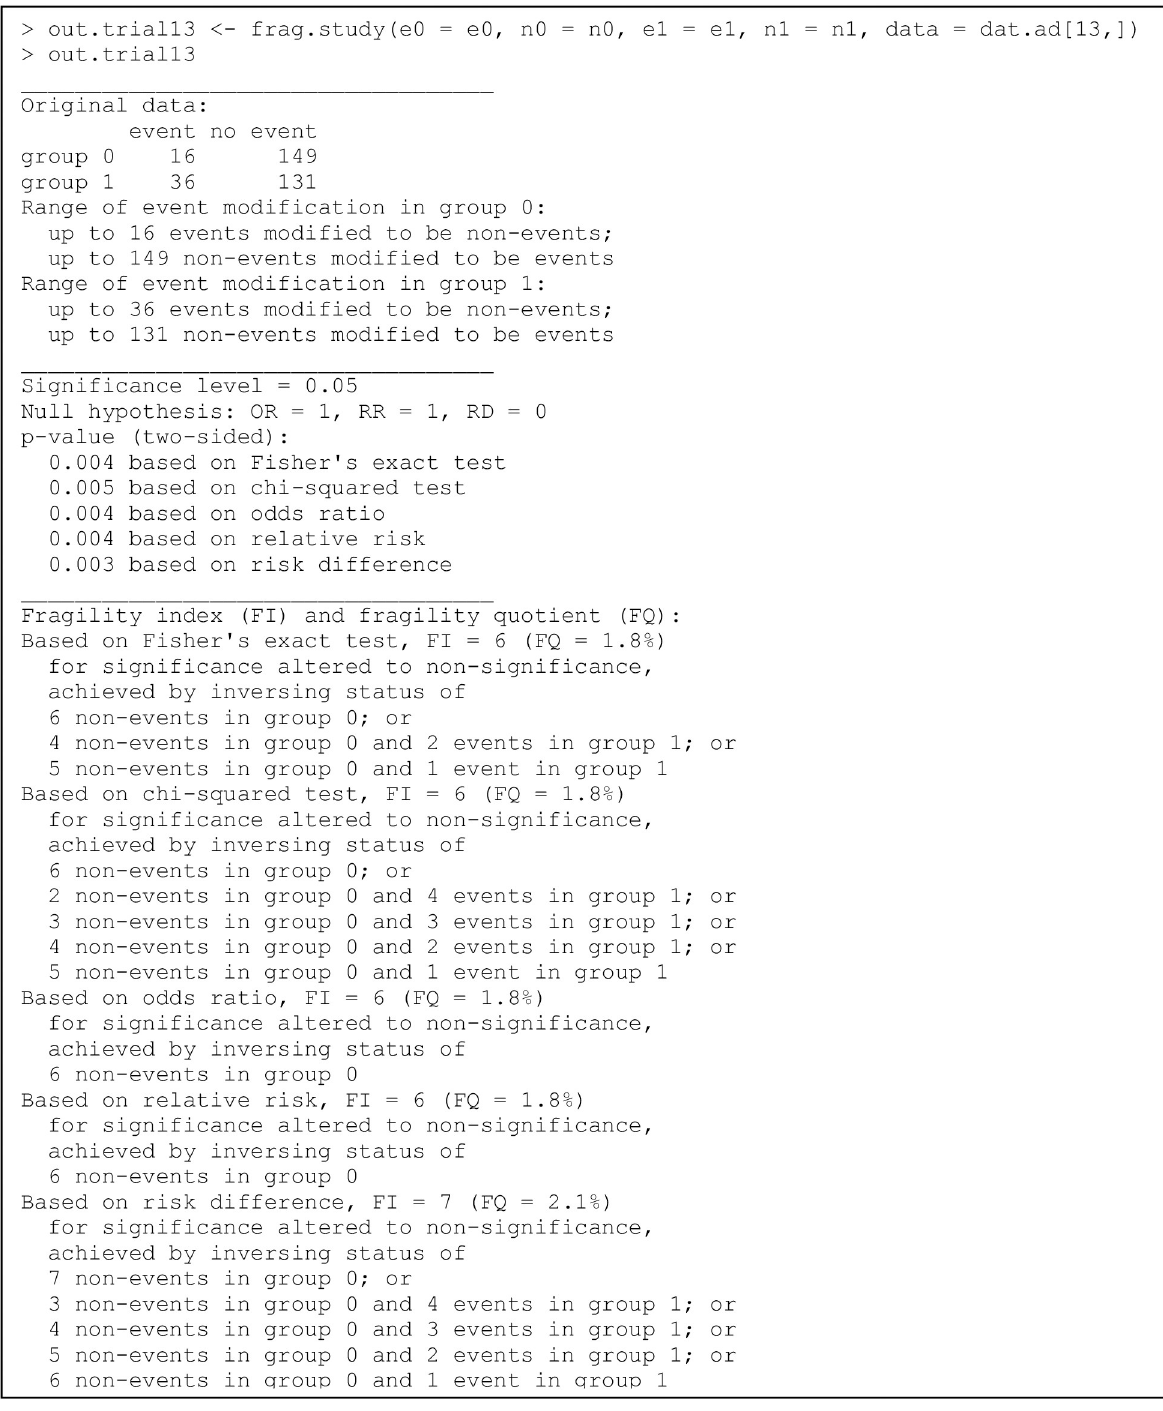
Fig 1. Output from the function frag.study() .